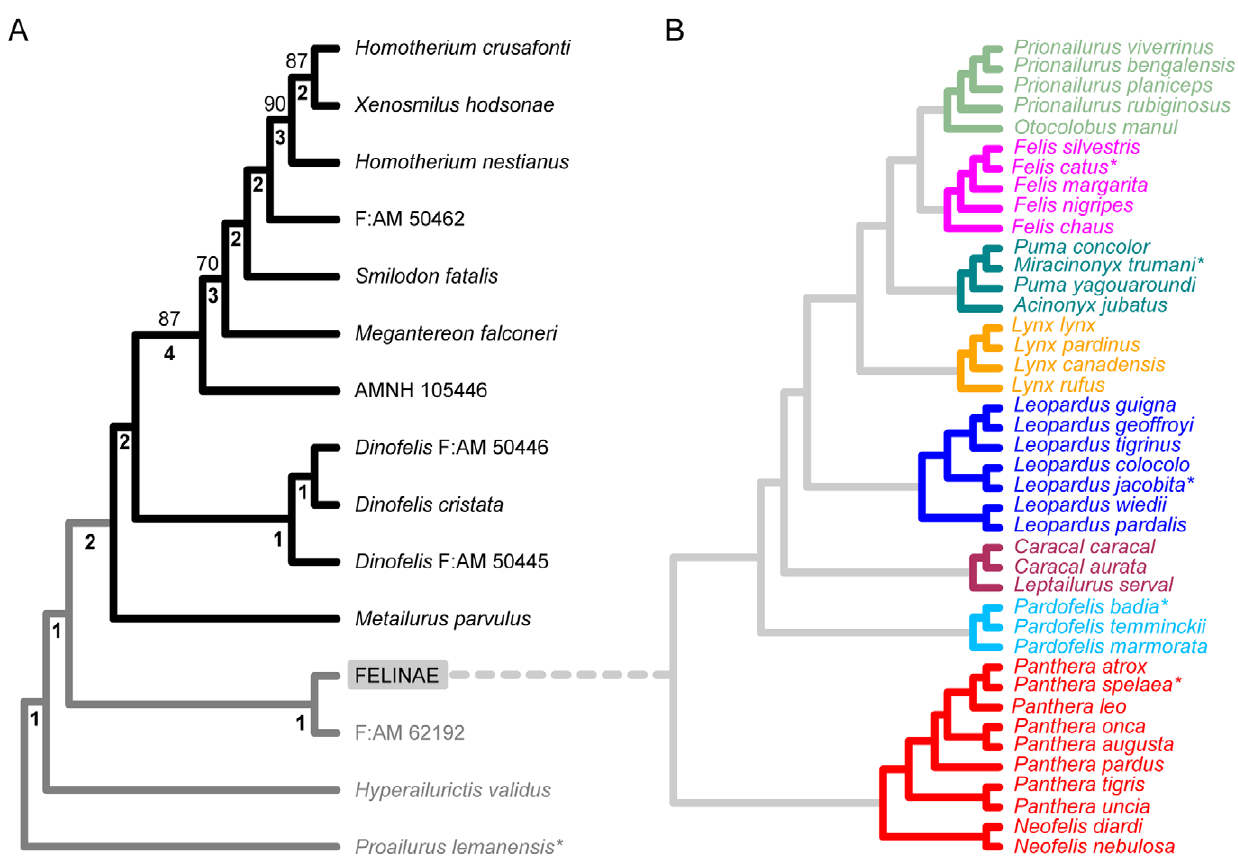
Figure 1. Phylogeny of the Felidae. (A) Single most parsimonious tree from the cladistic analysis, with Proailurus lemanensis as the outgroup. Felinae is treated as a single operational taxonomic unit (OTU) in the analysis, but is replaced with the topology in (B) for phylogenetic comparative analyses. Bootstrap percent support values and decay index values (in bold) are shown above and below each node respectively. (B) Internal relationships of Felinae based on [1], with extinct taxa inserted into relevant positions [27–29]. Asterisks denote taxa not included in the morphometric analysis, but employed in the phylogeny for dating nodes. Felid lineages are color-coded as follows: black, Machairodontinae; red, ‘Panthera’; sky blue, ‘Bay Cat’; maroon, ‘Caracal’; blue, ‘Ocelot’; orange, ‘Lynx’; green, ‘Puma’; pink, ‘Domestic Cat’; light green, ‘Leopard Cat’.